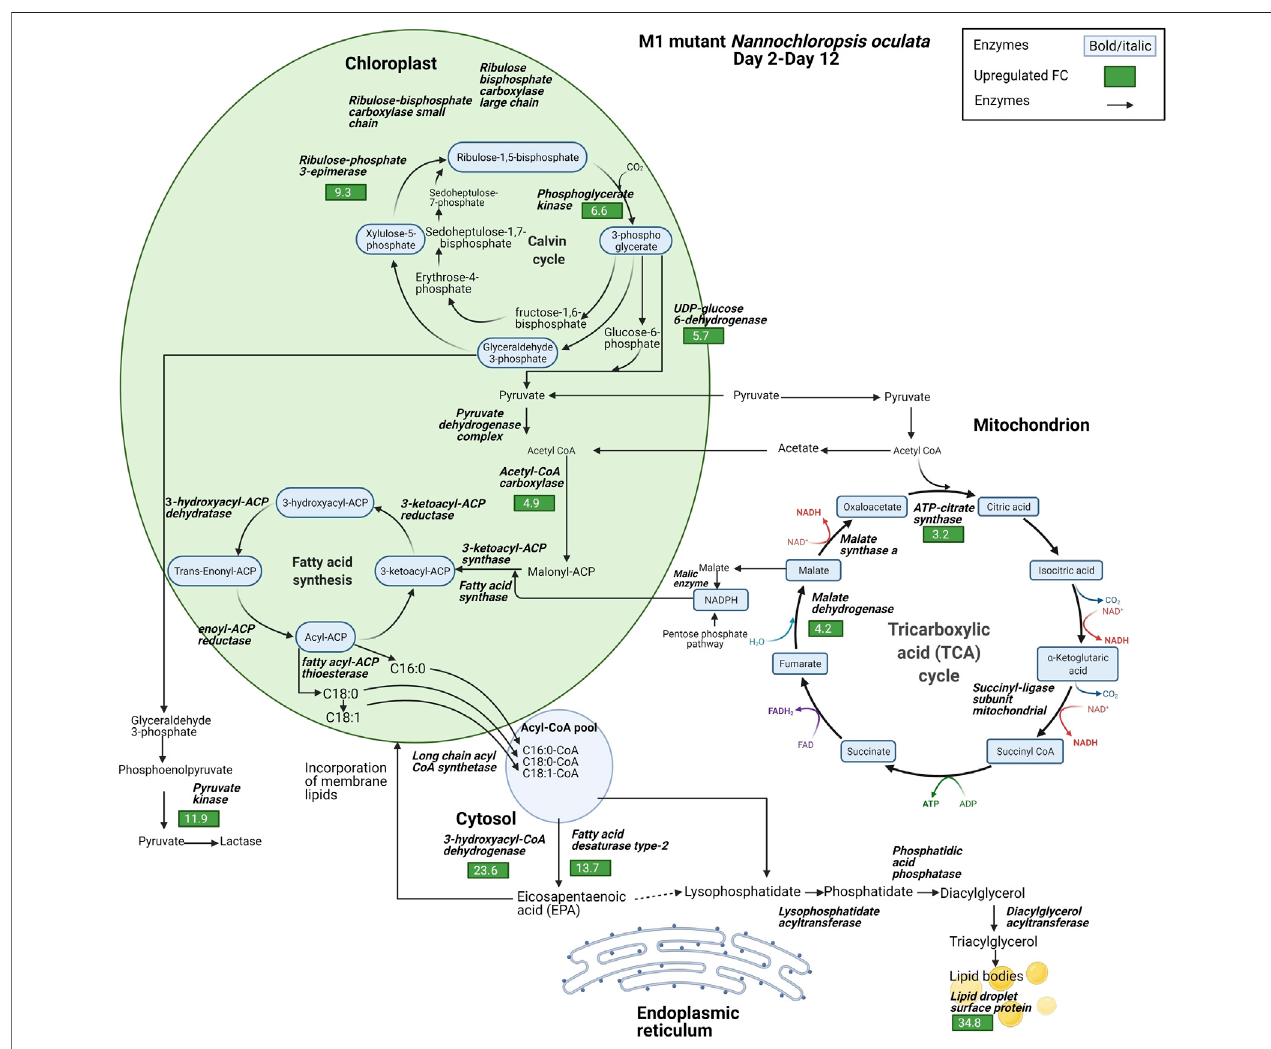
FIGURE 8 | Diagram of enzyme regulations from day 2 to day 12 for carbon fi xation toward TAG biosynthesis pathways for M1 mutant N. oculata . The diagram shows the pathways and their relation to fatty acid synthesis pathways. Signi fi cant quanti fi ed proteins are shown in the green and red boxes for upregulated and downregulated proteins,